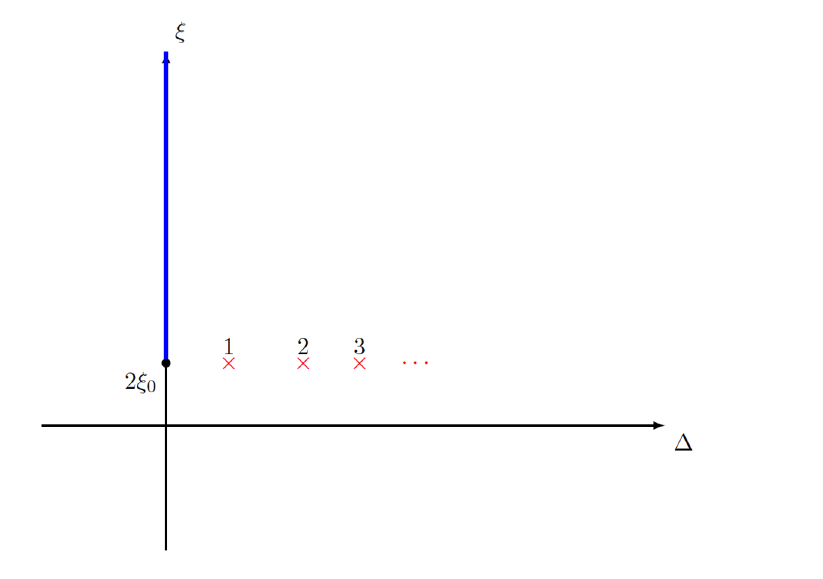
. From the ξ -viewpoint, it has a branch cut, while D 0